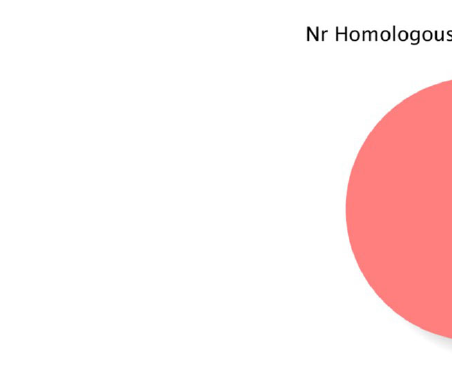
FIGURE 2 Species distribution of the top hits in homology search against the NR